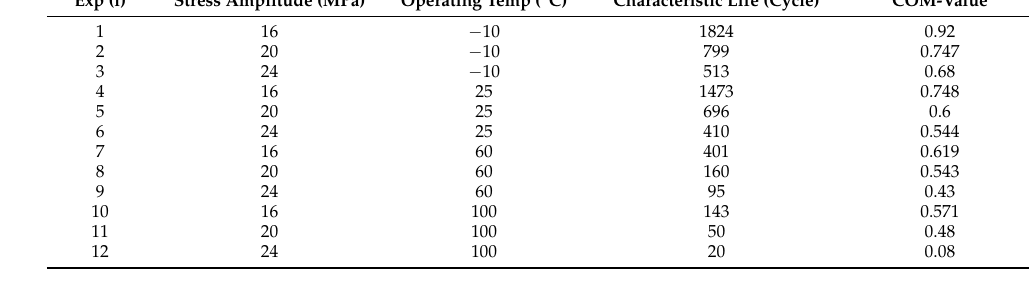
Figure 11. COG defuzzification